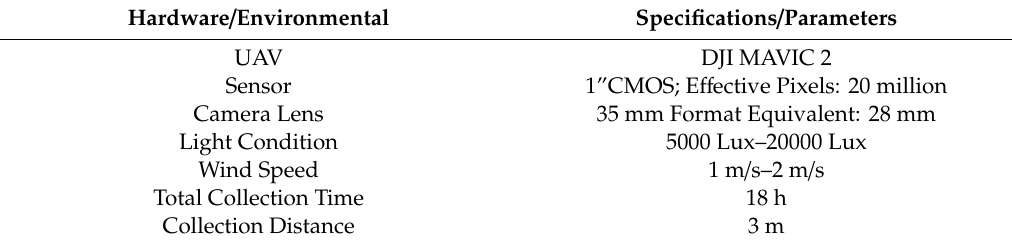
Table 1. Dam surface image collection equipment and environmental